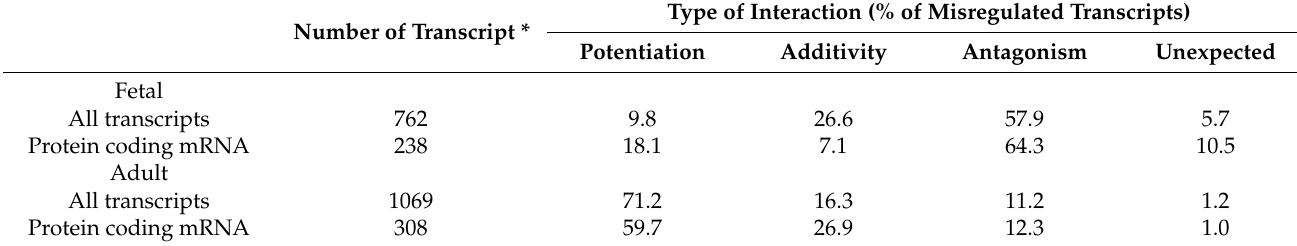
Table 1. Type of interaction between BPA and RAD on gene expression. Analyses were performed on a set of differentially expressed gene transcripts (all transcripts) and on a set of protein coding transcripts.